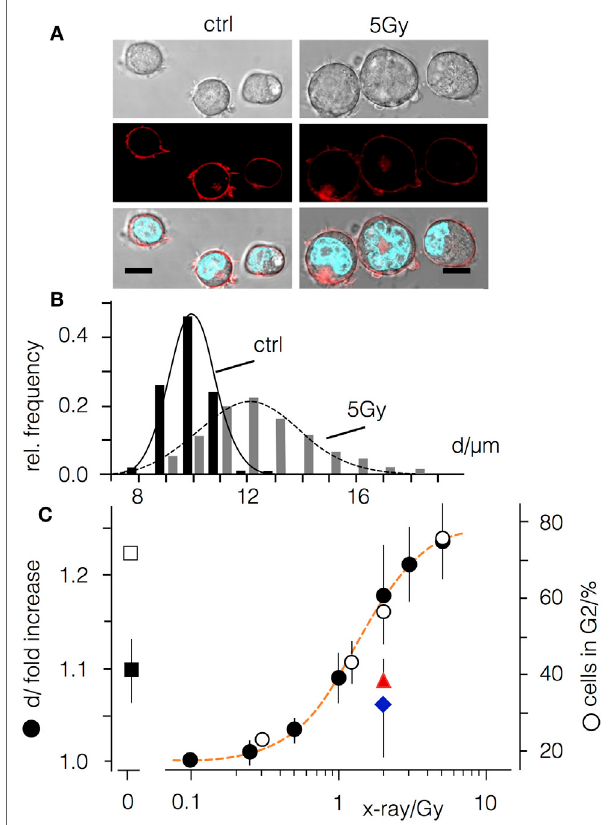
FigUre 1 | Ionizing irradiation causes an increase in diameter of Jurkat cells and an arrest in G2. (a) Images of Jurkat cells before and 48 h after X-irradiation with 5 Gy. Top row: wide field image, central row: confocal section in equatorial plane with fluorescent plasma membrane label CellMaskOrange ™ . Lower row: overlay of wide field image with CellMaskOrange ™ labeled plasma membrane and Hoechst labeled nucleus; scale bars 10 µm. (B) Cell diameter distribution of non-irradiated Jurkat cells (black bars) and cells irradiated with 5 Gy (gray bars). (c) Relative increase of cells in G2 phase of the cell cycle (open circles) and increase in cell diameter (d, closed symbols) in the absence (black circles) or presence of either 1 µM cyclosporine A (red triangle) or 50 µM BAPTA-AM (blue diamond). Square symbols show relative increase in cell diameter (closed symbol) and percentages of cells in G2 in non-irradiated cells treated with 3 µM CDK1-Inhibitor RO3306 (open